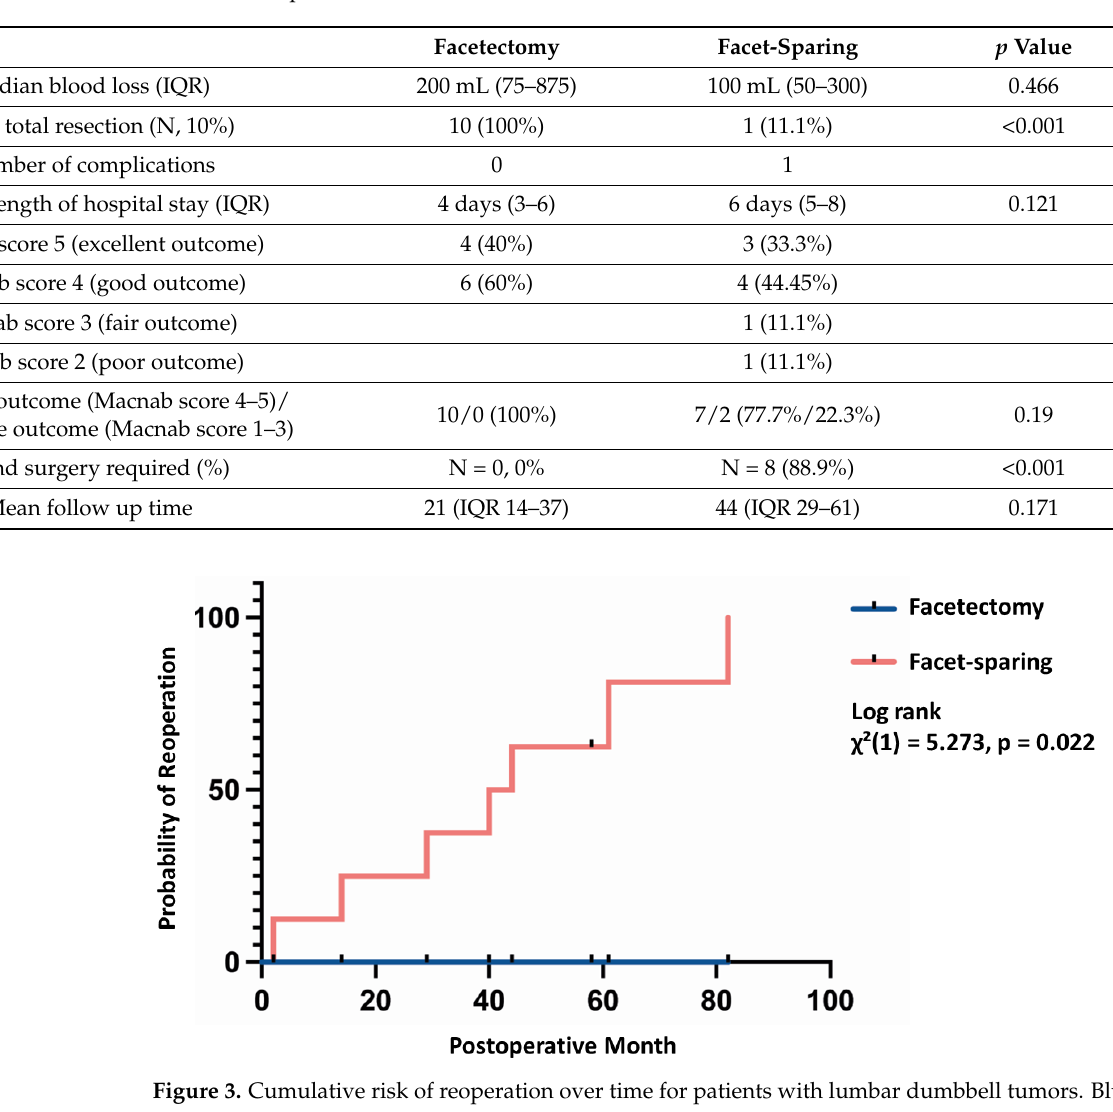
When analyzing the functional outcome post-operatively, we noticed that in the group ( p = 0.022).